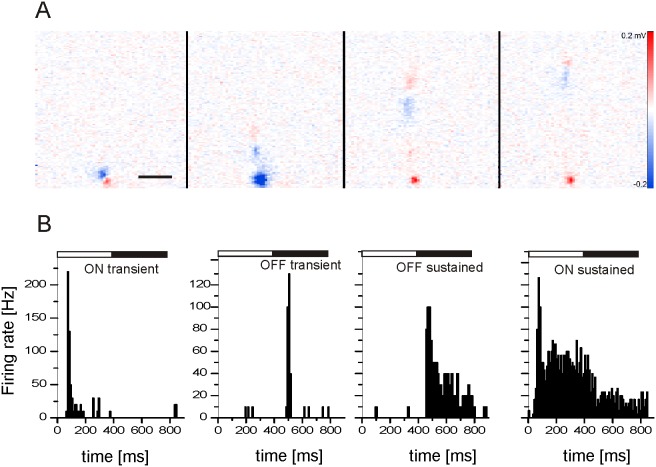
Identification of RGCs using the high-density multi transistor array.(A) Four consecutive electrical images acquired every 100 µsec reveal the occurrence and propagation of action potentials along the proximal axon. The electrical images were obtained after calculating the spike triggered average over more than thirty spikes. Visualization of the axon identifies a ganglion cell (Methods). Scale bar: 200 µm. (B) Typical light responses of four RGCs in wild-type retinas. The histograms were calculated for repeated stimulus presentations. (binsize: 5 ms).